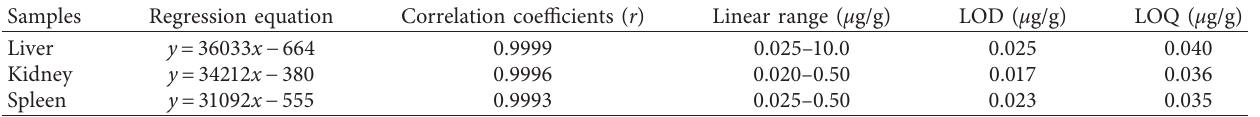
Table 1: The calibration curves, LOD, and LOQ of BB in different tissues ( n � 3).